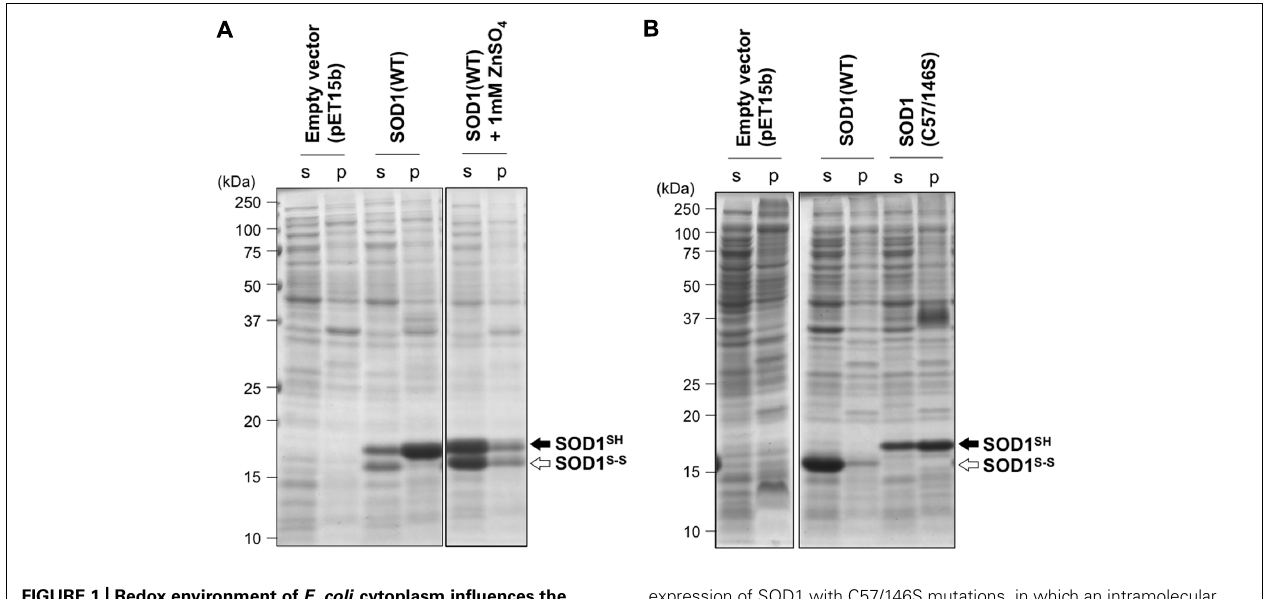
expression of SOD1 with C57/146S mutations, in which an intramolecular disulfide bond cannot form, was examined in E. coli SHuffle TM and shown in (B) . Cell lysates were fractionated into soluble supernatant (s) and insoluble pellets (p), treated with iodoacetamide, and then analyzed with non-reducing SDS-PAGE by using a 15% polyacrylamide gel.White (SOD1 S − S ) and black (SOD1 SH ) arrows at the right side of the gel image indicate positions of bands corresponding to SOD1 with and without a disulfide bond,